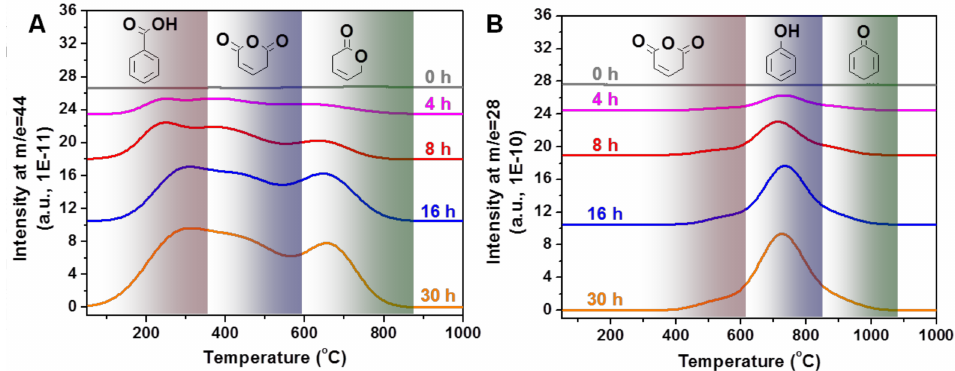
Figure 7. Temperature-programmed desorption (TPD) profiles showing the evolvement of CO 2 ( A ) and CO ( B ) as a function of the desorption temperature on the different oxidized samples at 250 ◦ C and with different treatment